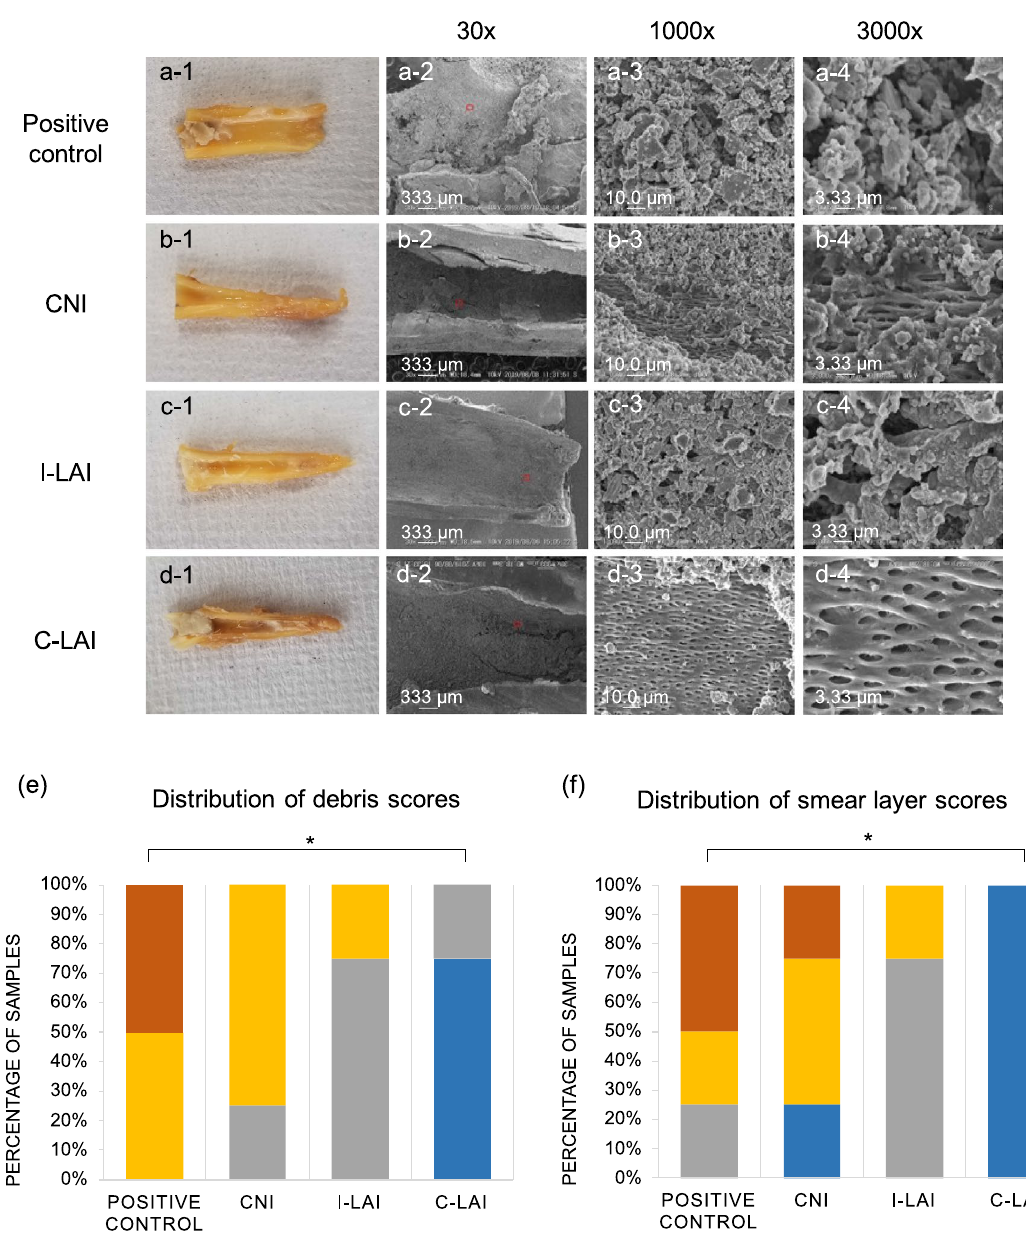
Figure 3. Typical images ( a-1 , b-1 , c-1 , and d-1 ) and SEM images (×30: a , b , c , and d-2 ; ×1000: a , b , c , and d-3 ; ×3000: a , b , c , and d-4 ) from each study group. In the high magnification image, a residual layer of biofilm was observed to cover the root canal wall in the positive control group, and the structure of the root canal wall could not be confirmed ( a-4 ). In the CNI and I-LAI groups, some openings of the dentinal tubules were observed compared with the positive control group, but some biofilm remained ( b-4 , c-4 ). In the C-LAI group however, almost no biofilm remained, and opening of both the dentinal tubules and the reticulated intertubular dentin structure could be observed ( d-4 ). The distributions of the scores for debris ( e ) and smear layer ( f ) are shown. In both instances, the C-LAI group showed significantly better scores than the positive